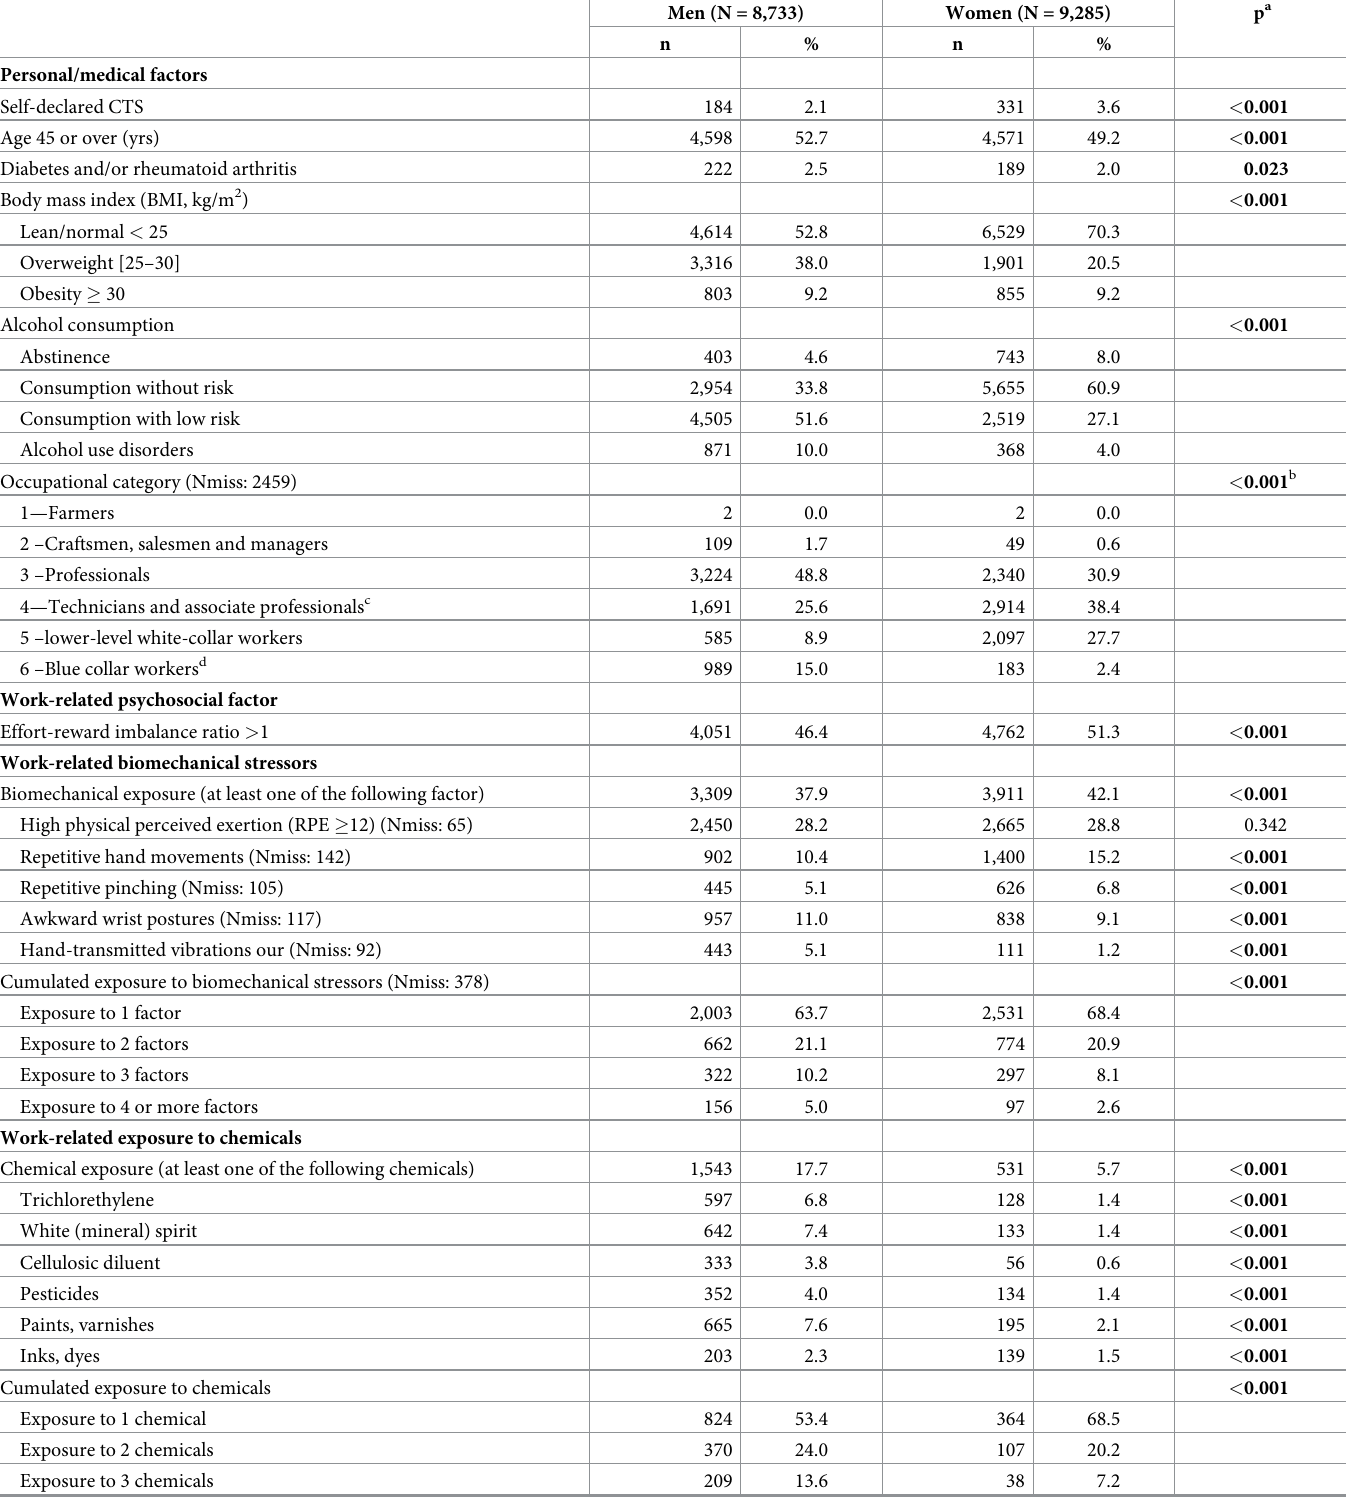
Table 1. Personal/medical factors and exposure to work-related factors in men and